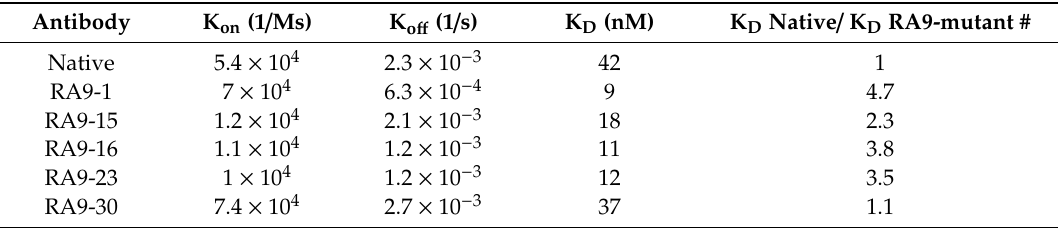
Table 1. K D of selected RA9-mutant clones (RA9-mutant number #—as indicated), full-length antibody clones were measured by BLI against biotinylated SLe a -PAA or biotinylated Le a -PAA, as a negative control.